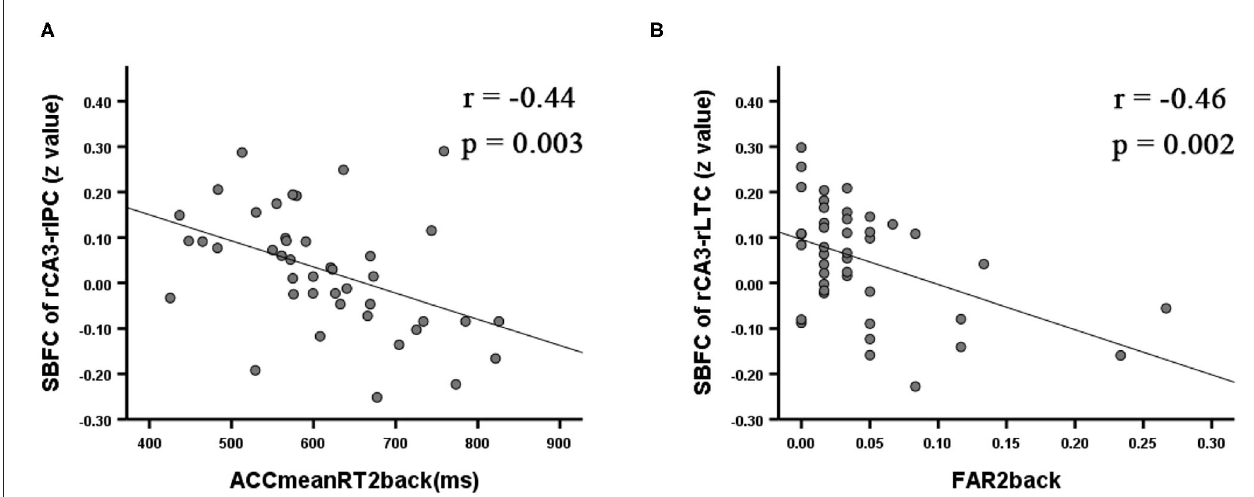
FIGURE 3 | Significant correlation for the rTLE patients between the VSWM_Nback scores and the mean z value of the SBFC in regions with significant alterations during intergroup comparisons ( p < 0.008 Bonferroni-corrected). ACCmeanRT2back was negatively correlated with the decreased SBFC of the rCA3-rIPC (A) . FAR2back was negatively correlated with the decreased SBFC of the rCA3-rLTC (B) . ACCmeanRT2back, mean reaction time for accurate responses in the 2back condition; FAR2back, false alarm rate for the 2back